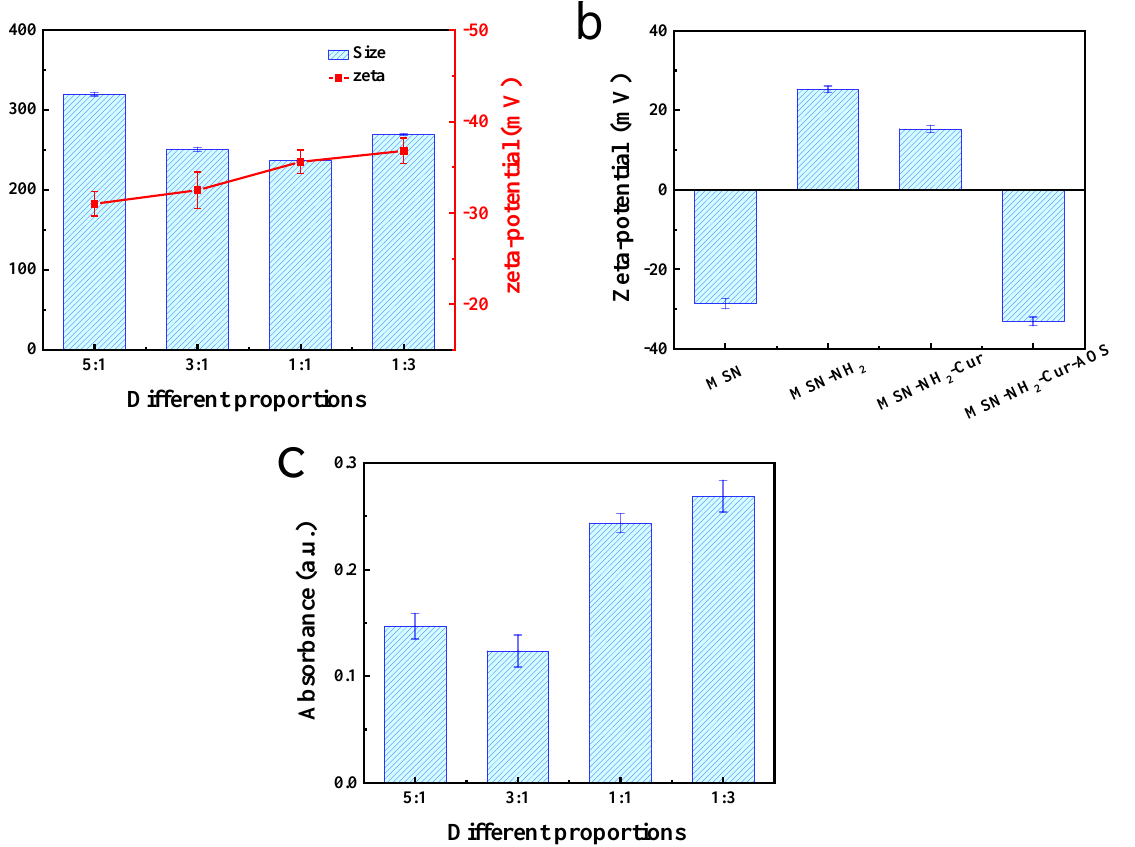
Figure 4. The particle sizes and zeta potentials of MSN-NH 2 -AOS prepared with different mass ratios of MSN-NH 2 and AOS ( a ). Zeta potentials of MSN, MSN-NH 2 , MSN-NH 2 -Cur, and MSN-NH 2 -Cur-AOS ( b ). Absorbance of Cur released from MSN-NH 2 -Cur-AOS nanoparticles with different mass ratios after loading the same content of Cur ( c ). Table 2. PDI of MSN-NH 2 -AOS prepared with different mass ratios of MSN-NH 2 and AOS. MSN-NH 2 /AOS (Mass Ratios)